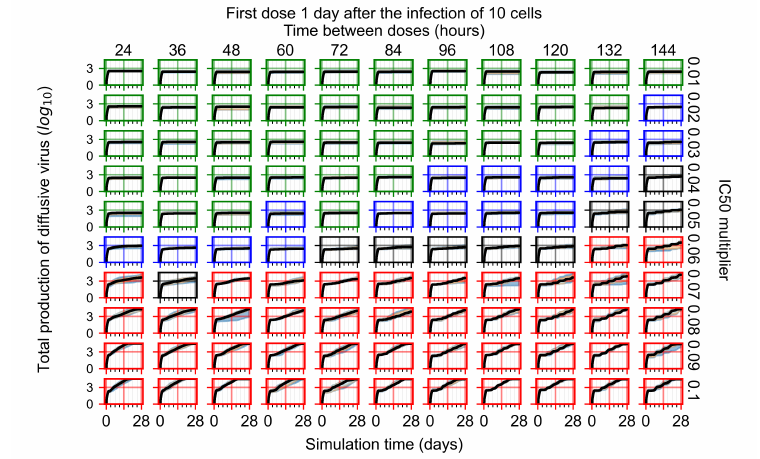
Figure A26. Total diffusive virus produced (AUC), Y axis in log scale, and exponent values as tick marks.